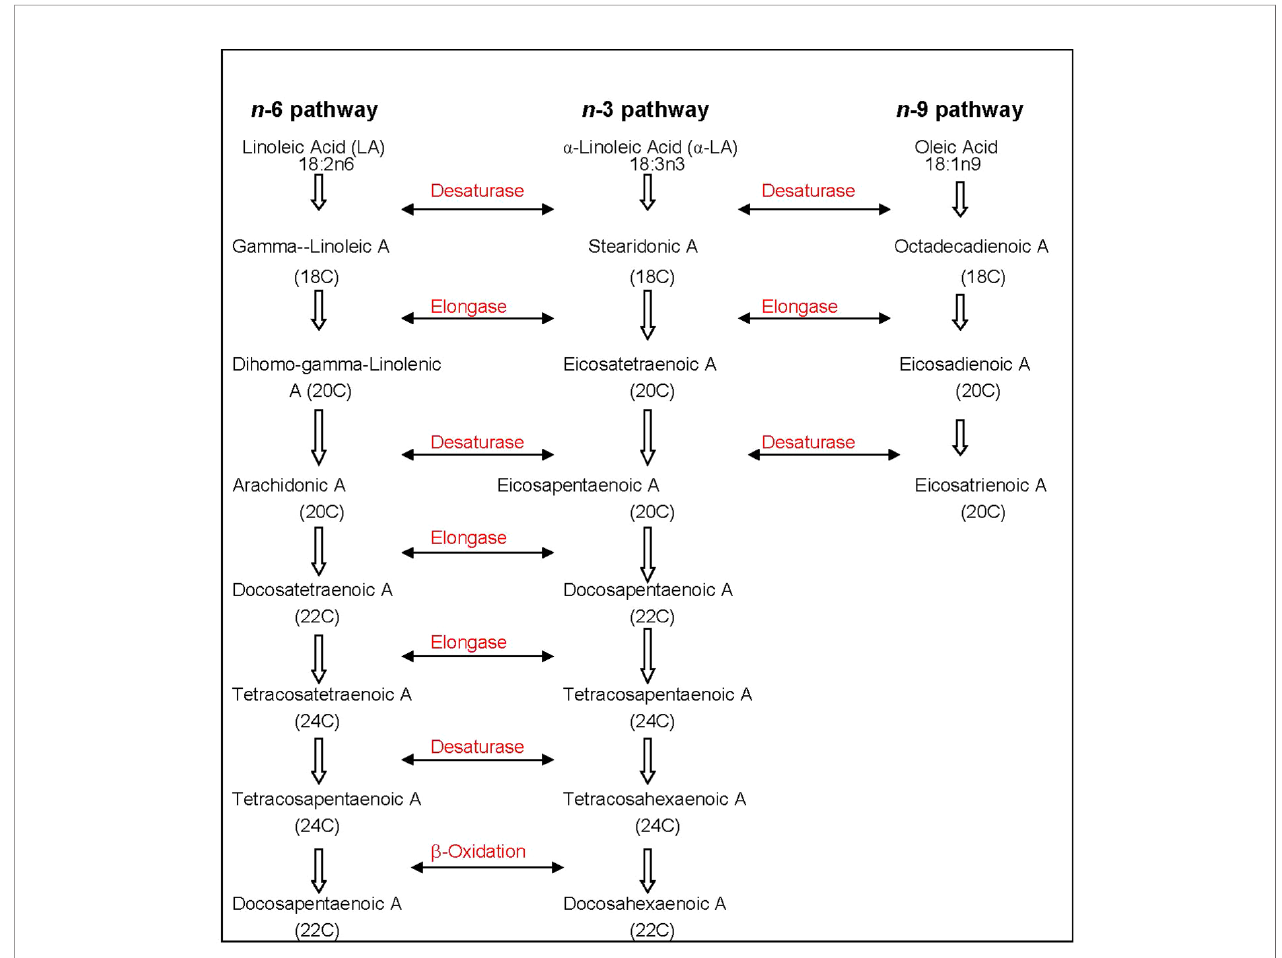
FIGURE 1 | Metabolic pathway of n -3 and n -6 PUFAs with desaturase and elongase enzymes. The af fi nity for n -6 PUFAs by these enzymes are higher compared to n -9; A, acid; C, carbon; PUFA, polyunsaturated fatty acid. References (Gurr, 1992; Vanek et al.,